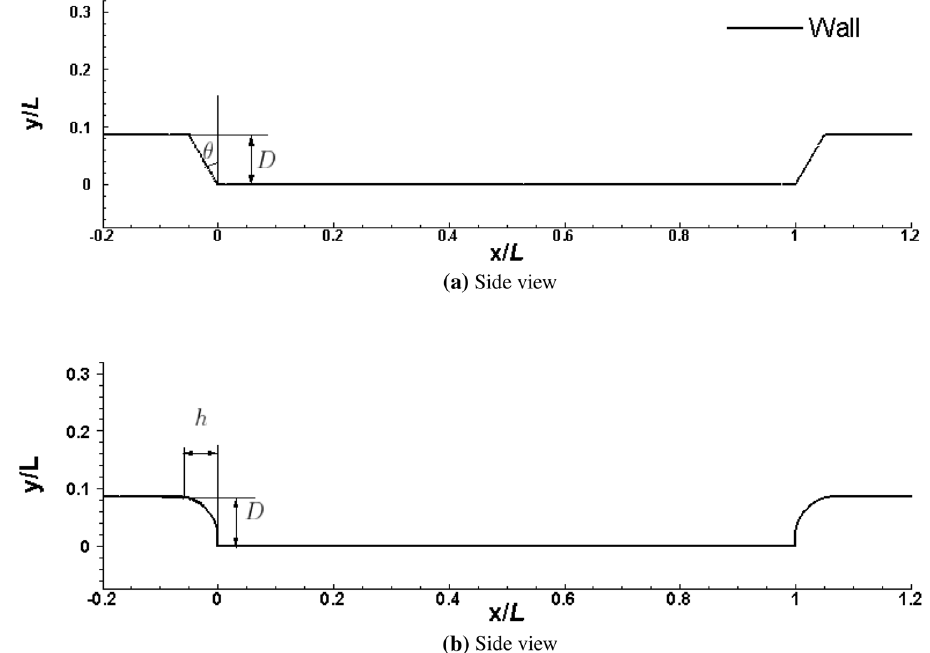
Fig. 3 Description of the